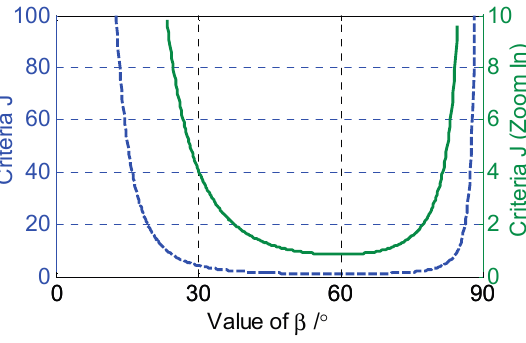
Figure 3. The relationships between the criteria J and the value of β